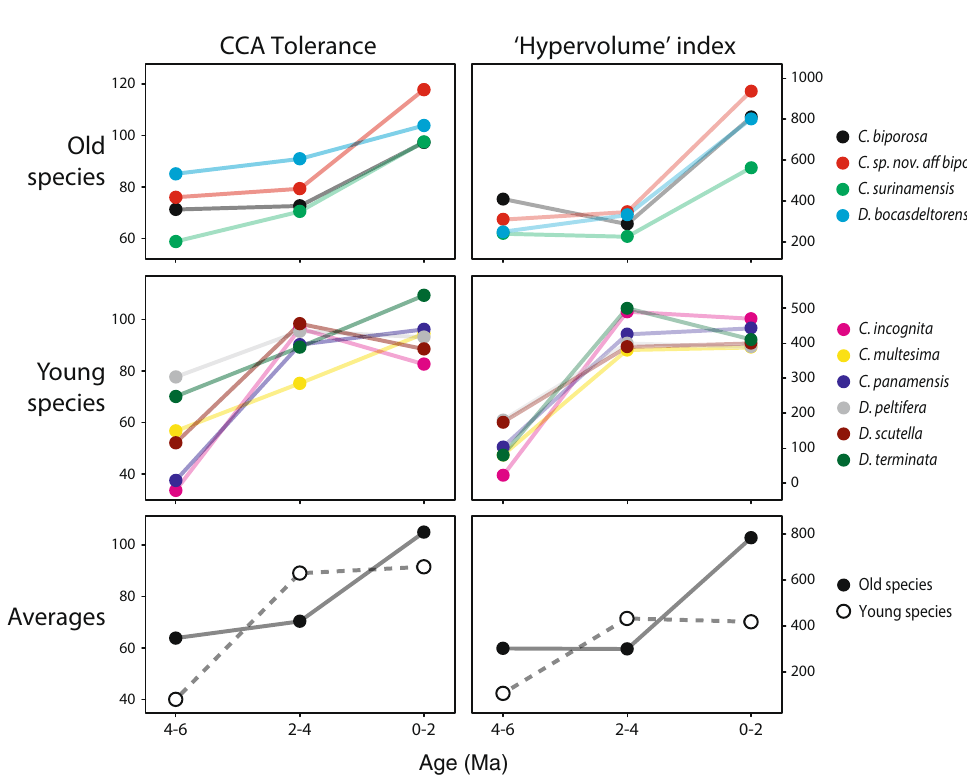
Figure 4. Expansion of habitat breadths of cupuladriid species in the southwestern Caribbean over the last 6 myr. Estimates of habitat breadth are split into old species (top), young species (middle) and averages of old and young species (bottom). Old species originated before 8 Ma and young species after 5 Ma. We calculated two estimates of cupuladriid habitat breadth - CCA Tolerances (aka RMSTOL 40,85 ) (left) and Hypervolume index